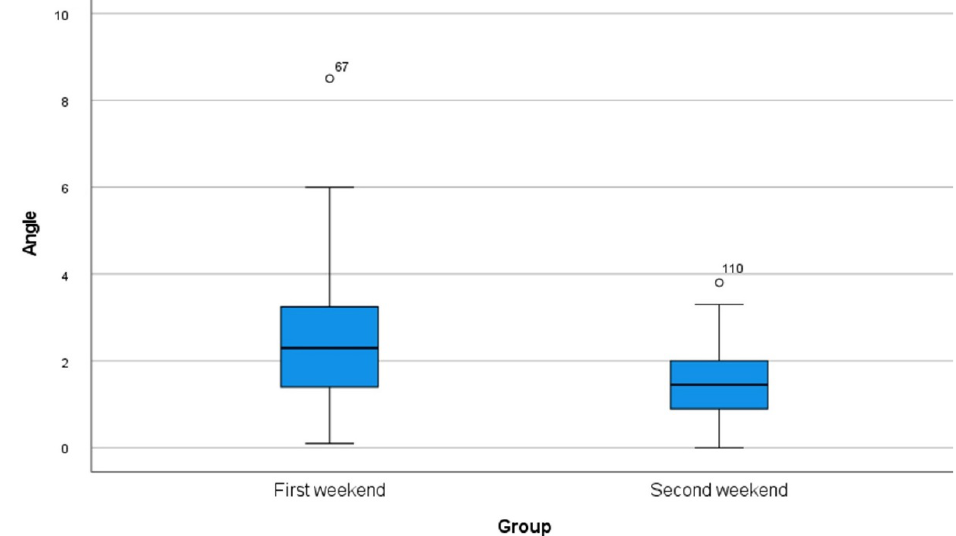
Figure 4. Box plot of all measurements of deviations in the angle regarding the master typodont.